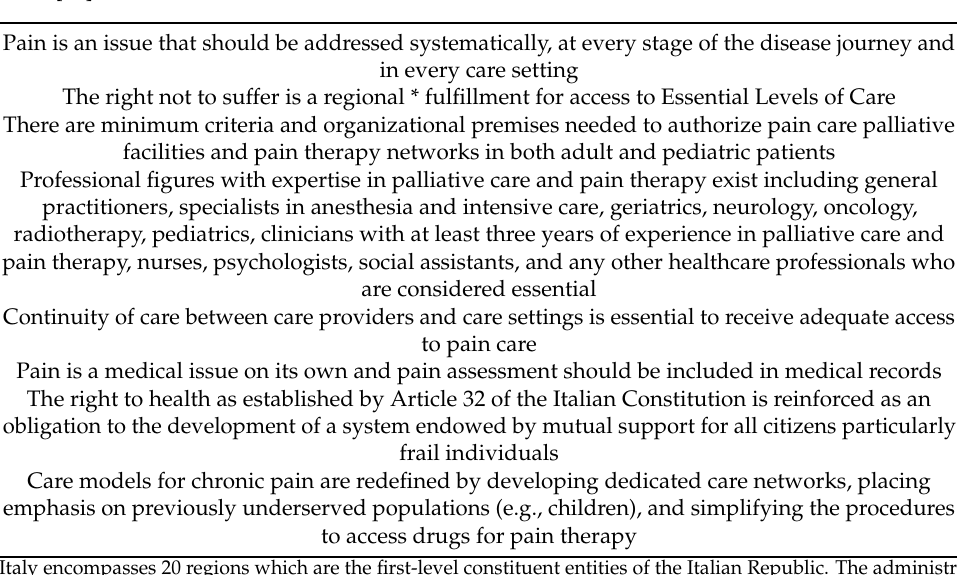
Table 1. Snapshot of the main features and clinical implications of Law 38/2010. Elaborated from the text in [12].